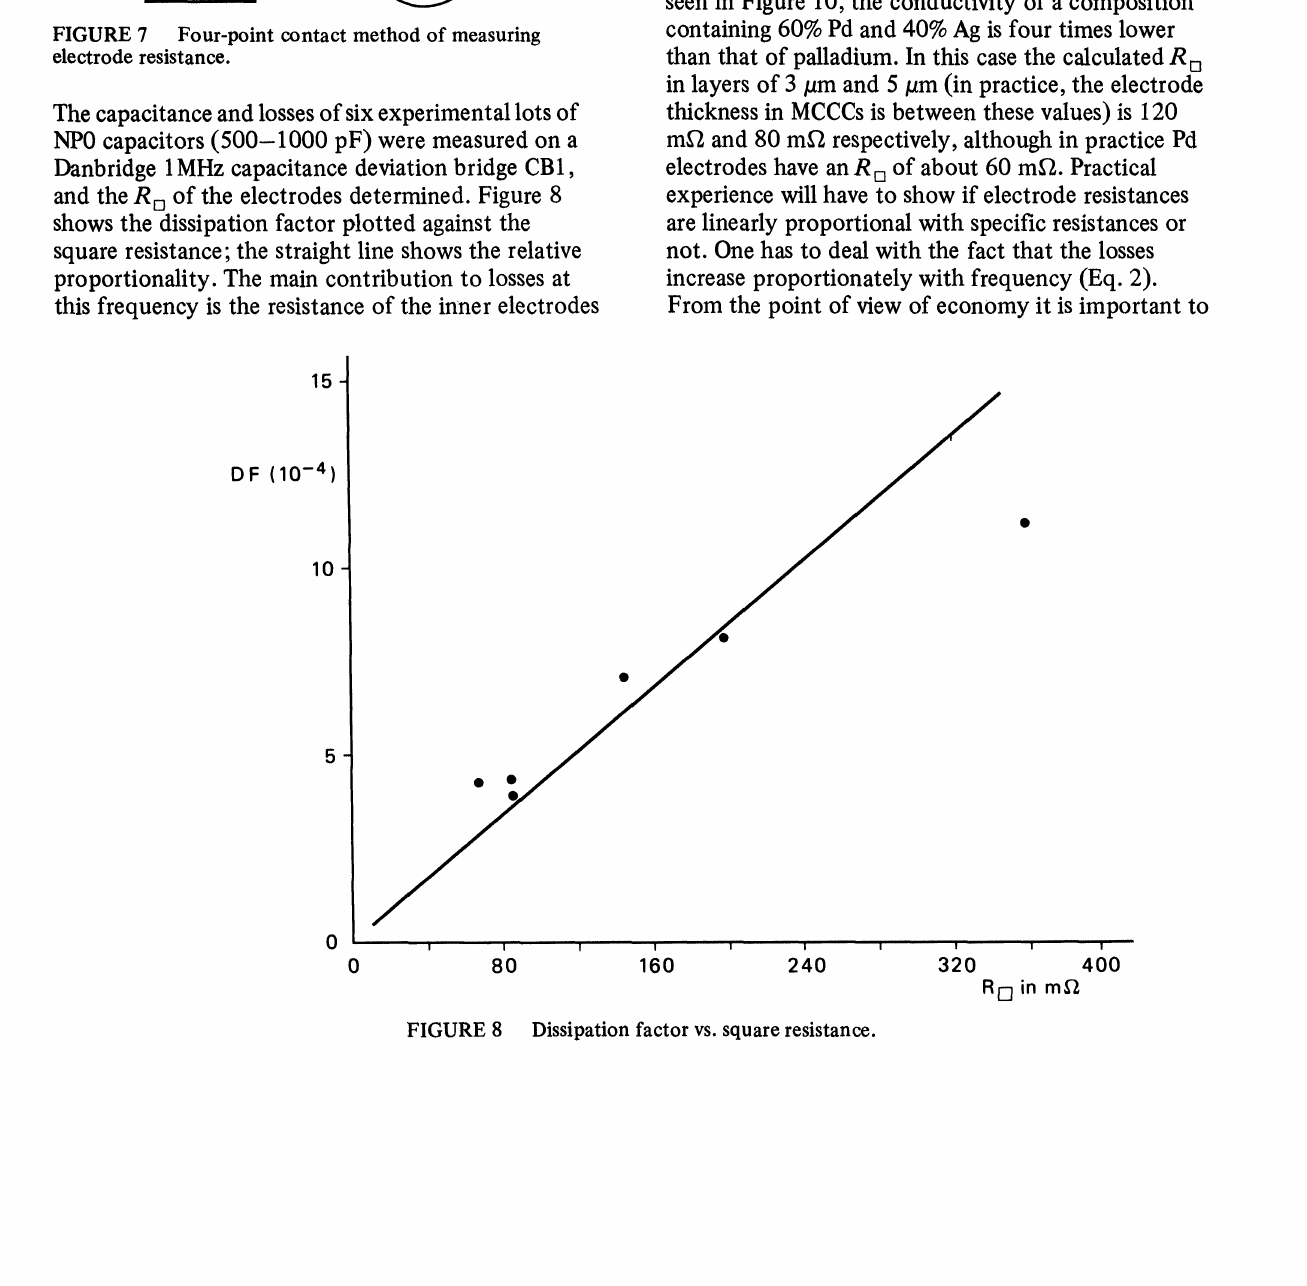
Four-point contact method of measuring electrode resistance. The capacitance and losses of six experimental lots of NP0 capacitors (500-1000 pF) were measured on a Danbridge 1MHz capacitance deviation bridge CB1, and the Rr of the electrodes determined. Figure 8 shows the dissipation factor plotted against the square resistance; the straight line shows the relative proportionality. The main contribution to losses at this frequency is the resistance of the inner electrodes